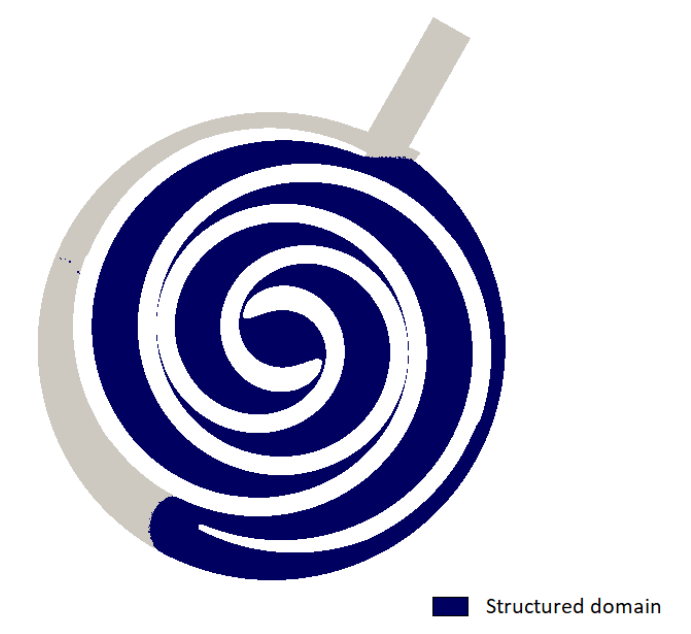
Figure 1. Structured domain of the scroll